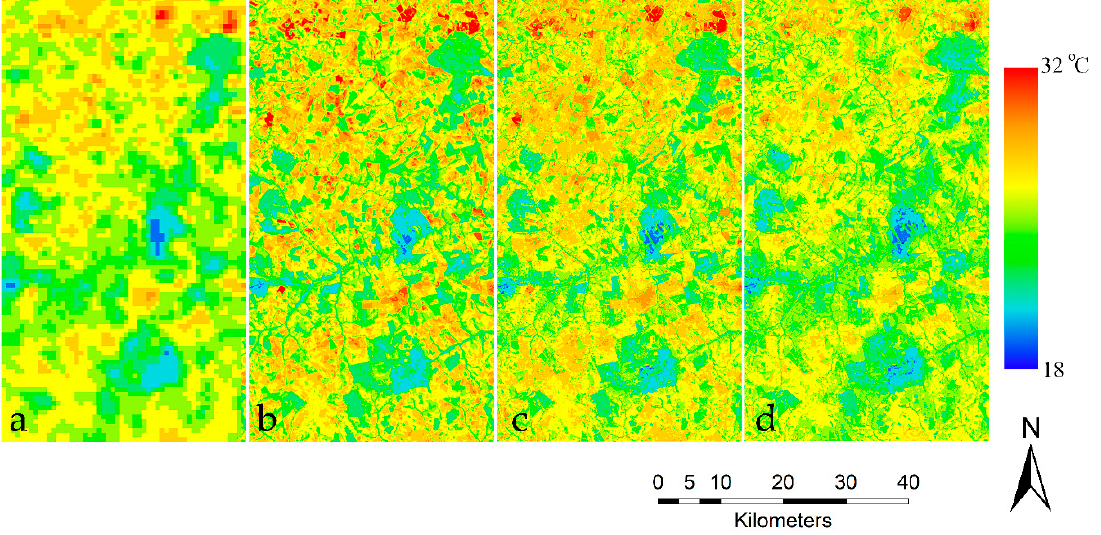
Figure 6. Sharpening BT images from a 960-m to 60-m resolution for Site 2. ( a ) Sentinel-3 BT at 960 m.